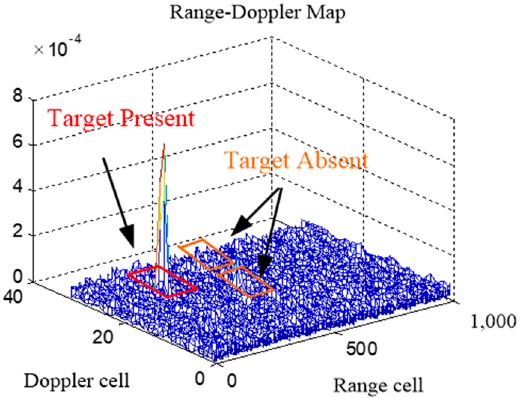
Figure 23. Target present and Target absent in Range ‐ Doppler Map.